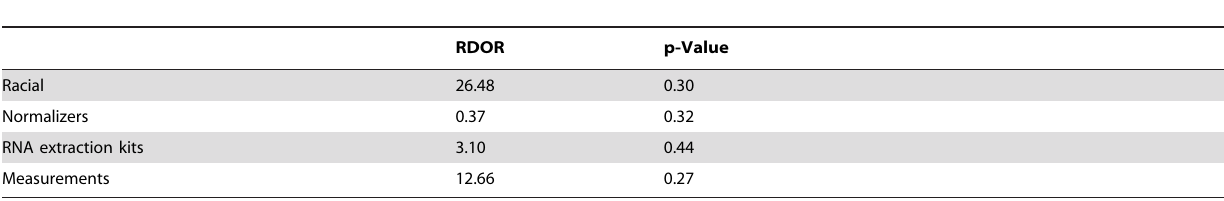
Table 2. RDOR and P-values of covariants in the meta-regression